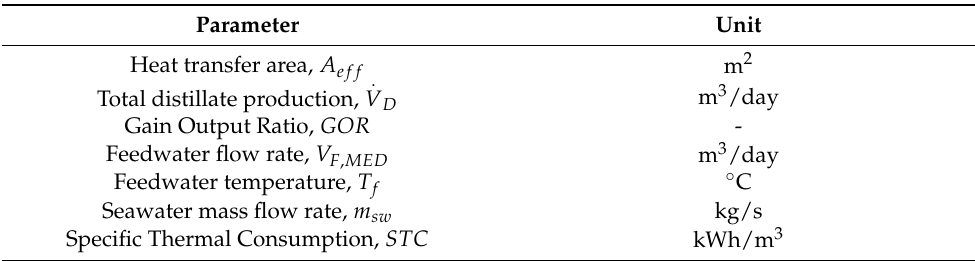
Table 4. Output data from the LT-MED model.